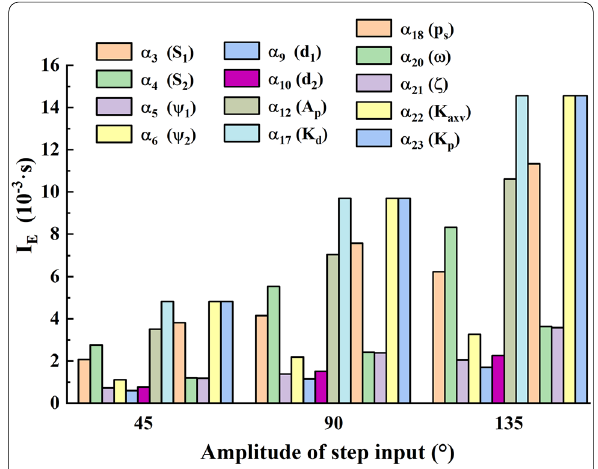
Figure 17 Histogram of sensitivity index under different step inputs and 200 N